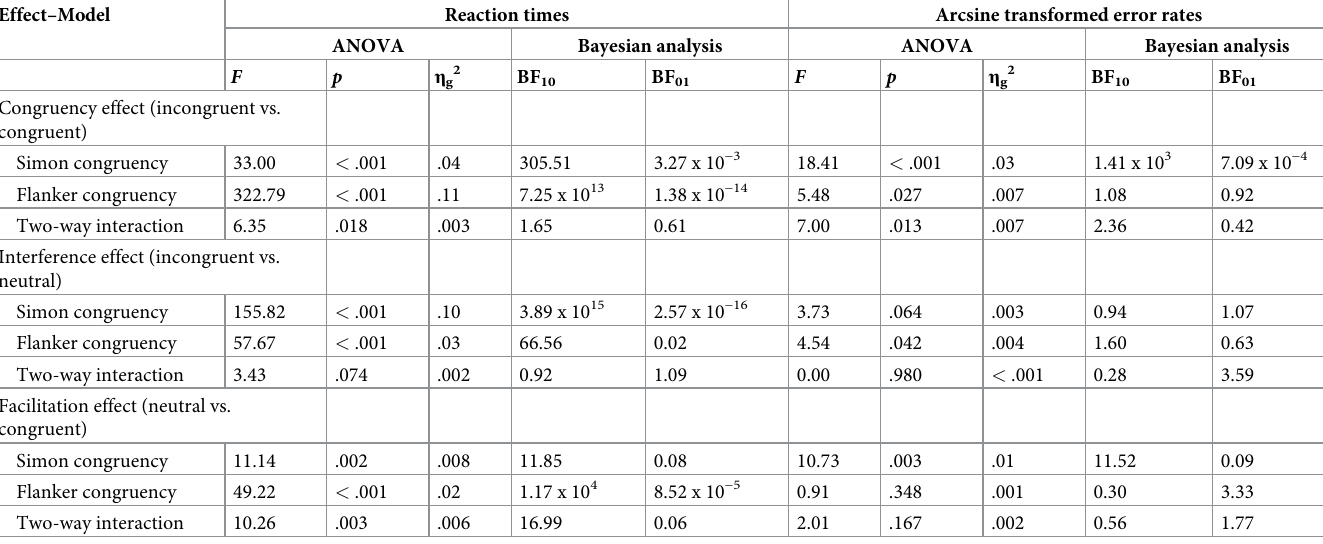
Table 2. Experiment 1a: Inferential statistical values for the two-way repeated-measures analysis of variance (ANOVA) with the variables Simon congruency and flanker congruency, and Bayes Factors (BF) from model comparisons. Effect–Model